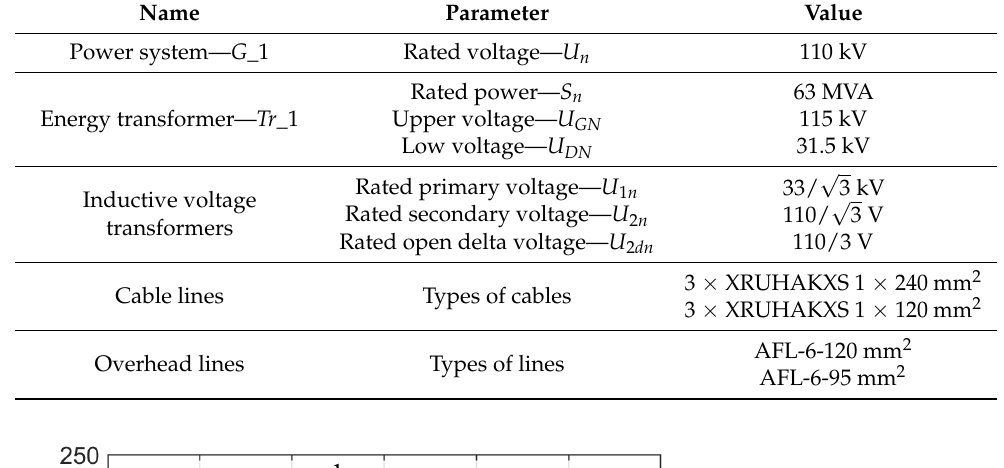
Table 1. Parameters of the power grid model analyzed.